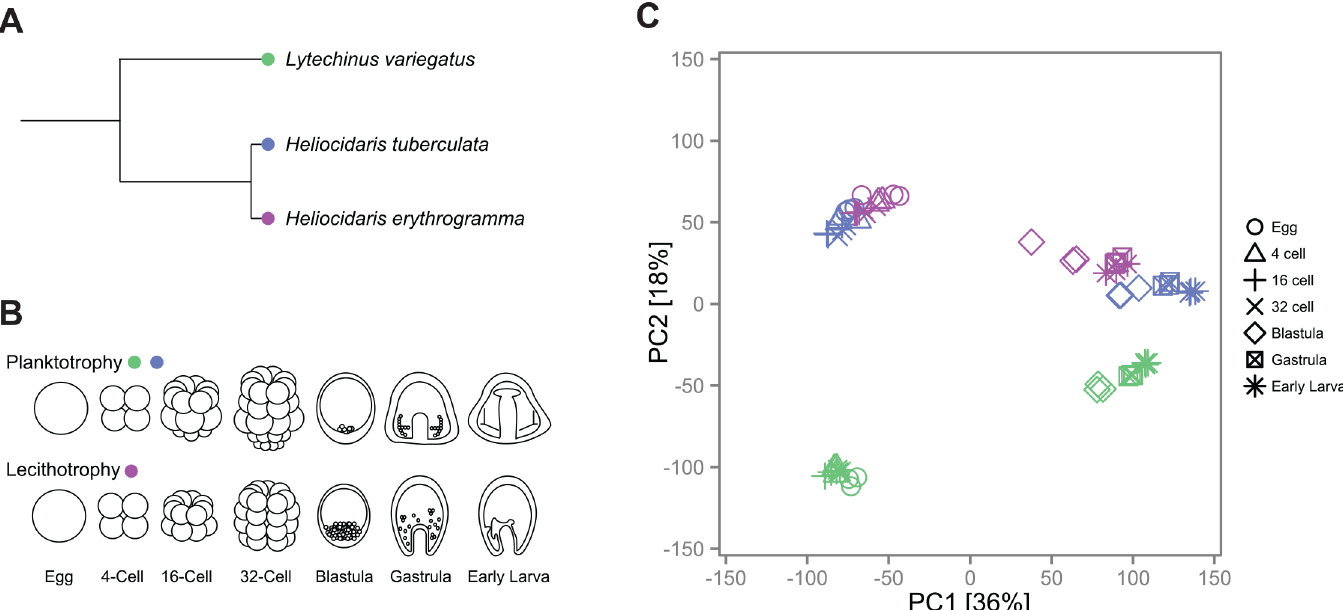
Fig 1. Gene expression during sea urchin development reflects known phylogenetic relationships between species. ( A ) Our study includes three sea urchin species: the sister species H . tuberculata (planktotroph) and H . erythrogramma (lecithotroph), which diverged approximately 5 Myr, and an outgroup species L . variegatus (planktotroph), which diverged approximately 35 – 45 Myr ago [44, 50]. ( B ) Our developmental time course includes seven stages across each species, from unfertilized eggs to early larvae. ( C ) Principal component (PC) analysis of gene expression (S1 Data). PC1 explains 36% of the overall variation and clearly separated early (egg through 32-cell stage) from later developmental stages (blastula through early larva), whereas PC2 separated L . variegatus from the two Heliocidaris species, corresponding to their phylogenetic relationships.